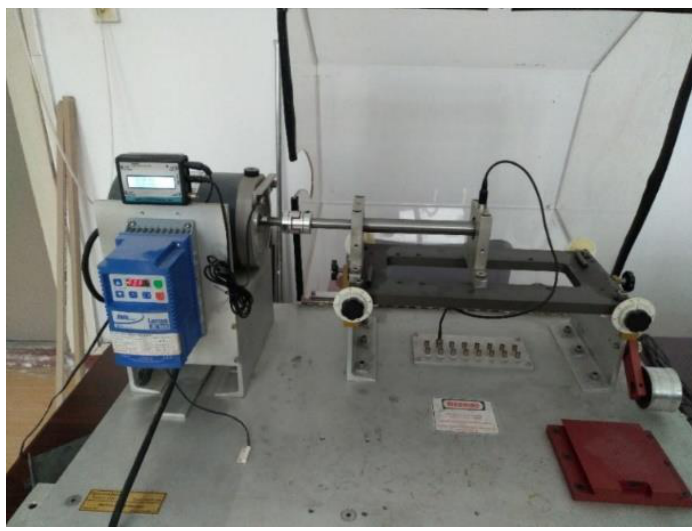
Figure 6. Test rig used to collect different speeds and different sample rate data.